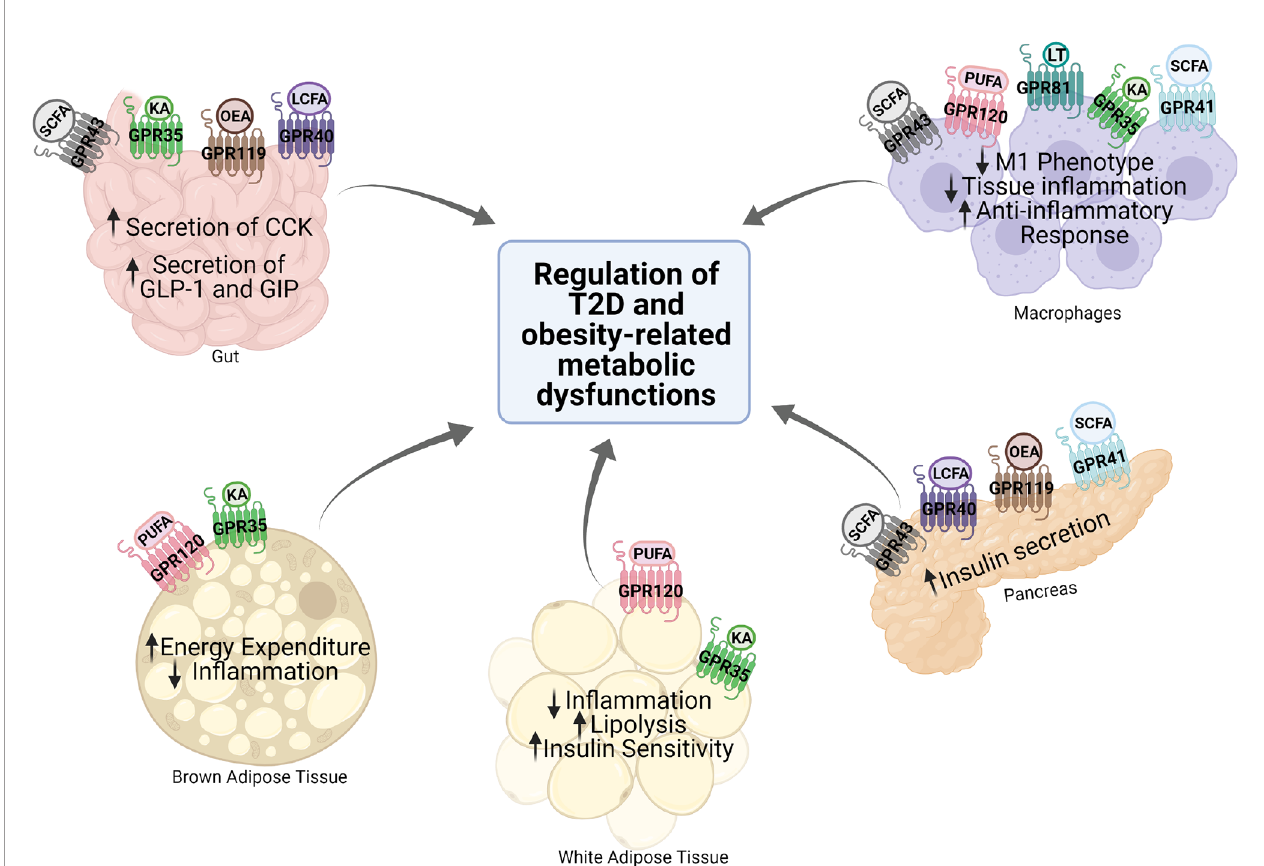
FIGURE 1 | Expression and function of various GPCRs in metabolic tissues. Various GPCRs target insulin resistance, obesity, and T2D-related pathophysiology in the metabolic tissues. KA, kynurenic acid; LCFA, long-chain fatty acid; SCFA, short-chain fatty acid; OEA, oleylethanolamide; PUFA, polyunsaturated fatty acid; CCK, cholecystokinin; GLP-1, glucagon-like peptide 1; GIP, gastric inhibitory